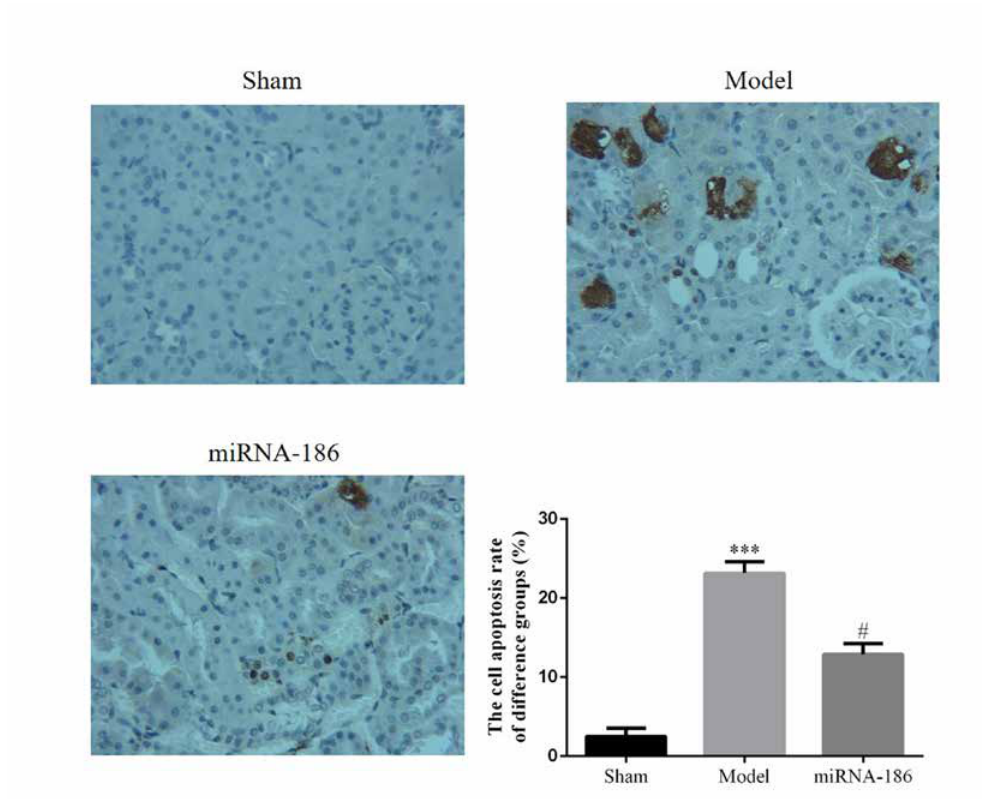
Figure 2: The cell apoptosis rate of difference groups, ***: P < 0.05, compared with Sham group, #: P < 0.05, compared with Model